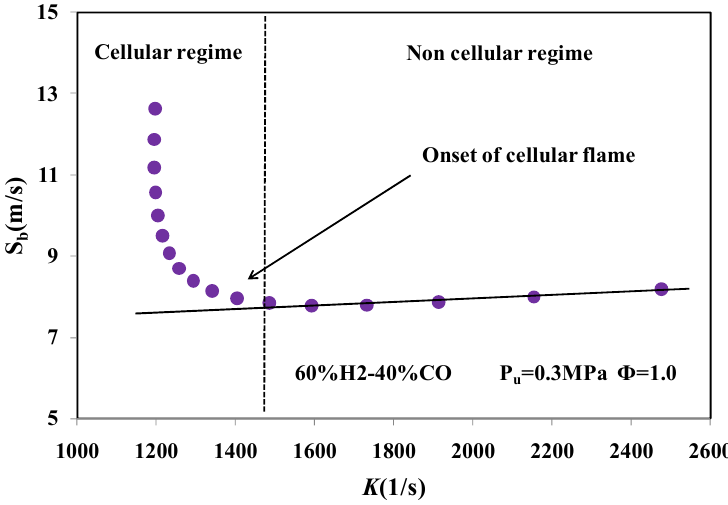
Figure 11. Stretched flame speed versus stretch rate.